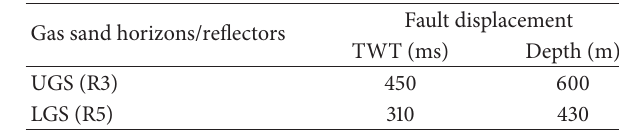
Table 2: Show identified fault displacement magnitude of gas sand horizons in the